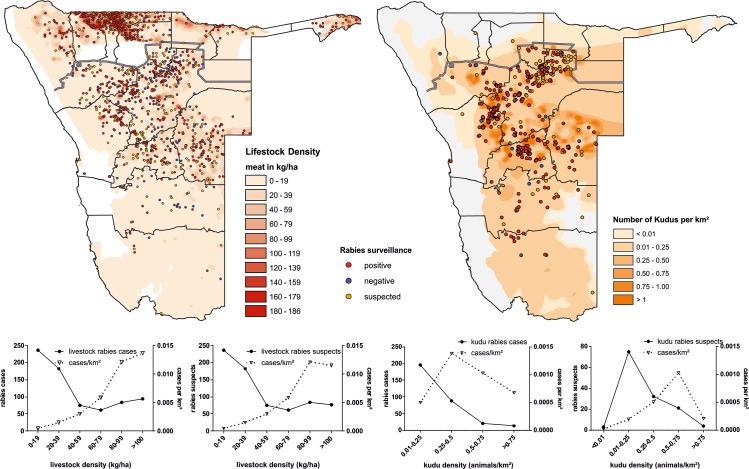
Spatial display of surveillance data (2011–2017) for livestock animals (left), kudus (right).Densities of kudus and livestock are indicated. Below: charts showing the absolute number of rabies cases or rabies suspects per density class (left y-axis) and the density of rabies cases or rabies suspects per square kilometer per respective density class (right y-axis).